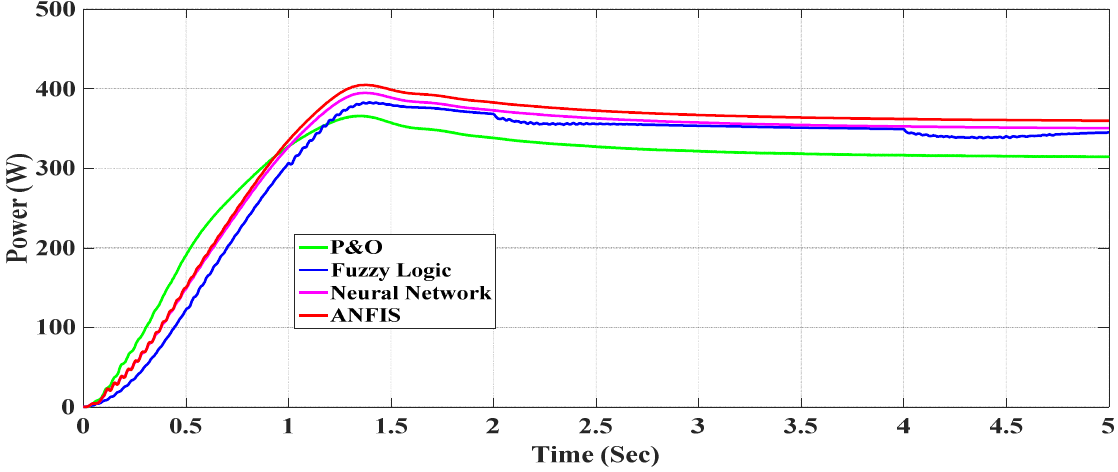
Figure 36. Output Power of WTIG Framework using P-&-O, F-LC, AN-N and AN-FIS MPPT Controllers to the variation in WS.